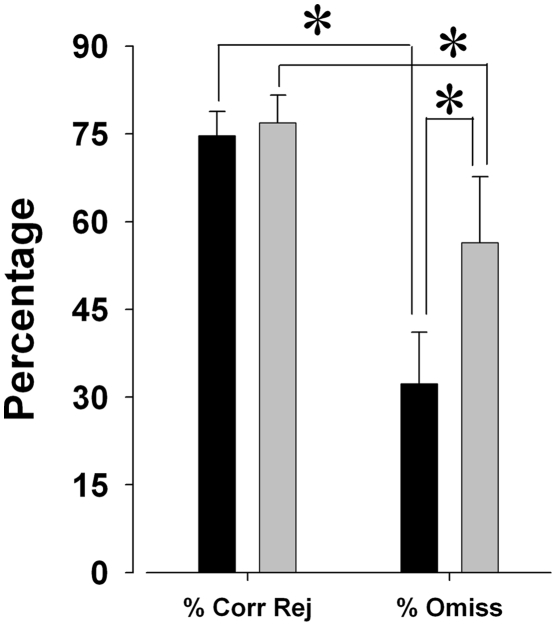
Comparison of percentage non-responding in no-go vs. go trials in the 5C-CPT.Given the similarity in response type for a correct rejection in a no-go trial to a miss in a go trial (both are represented by a lack of response), it is important to establish that the performance of the mice is dependent upon trial type. C57BL/6J and DBA/2J mice exhibited comparable levels of %Correct Rejection (%Corr Rej) during no-go trials in the extended session 5C-CPT. During go trials however, C57BL/6J mice exhibit significantly lower levels of %Omissions compared to DBA/2J mice. Importantly, both groups exhibited significantly different levels of non-response to each trial type, suggesting that they performed differently during go trials compared to no-go trials, and hence they their response was dependent upon trial type. Data presented as mean+s.e.m., and * denotes p<0.05.